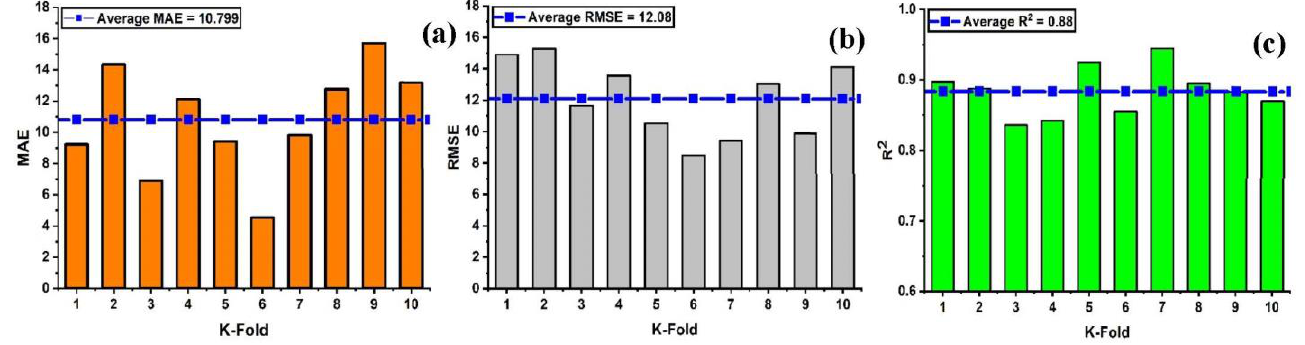
Figure 8. Cross validation; ( a ) SVR with MAE; ( b ) SVR with RMSE; ( c ) SVR with R 2 .